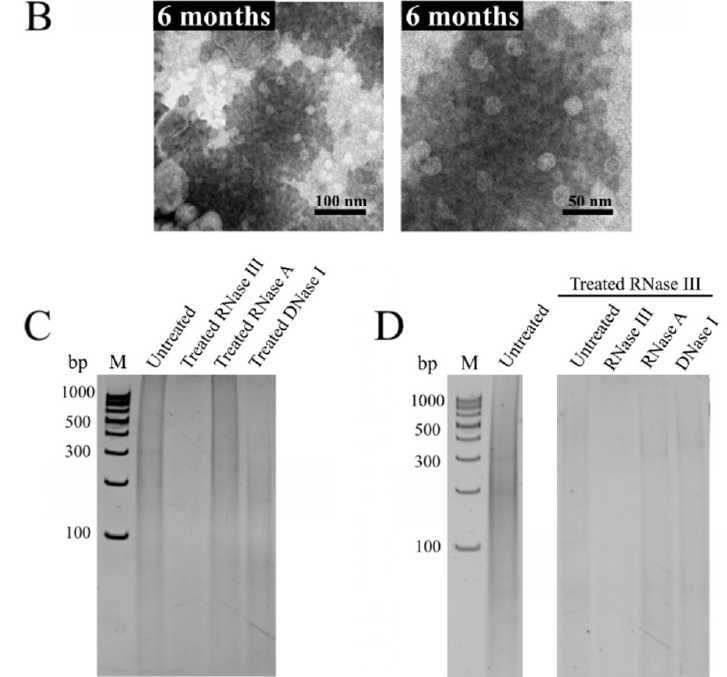
Figure 3. Characterization of recombinant Linked cp Pst DNV-ds pro counterpart. ( A ) Transmission electron micrograph of Linked cp Pst DNV-ds pro (Linked Pst DNV VLPs-ds pro ). ( B ) Linked Pst DNV VLPs-ds pro after 6-month storage at 4 ◦ C. ( C ) The presence of dsRNA on the outer surface of Linked Pst DNV VLPs-ds pro . Total RNA isolated from purified recombinant VLP was directly treated with either RNase III, RNase A or DNase I. ( D ) The encapsulated dsRNA in Linked Pst DNV VLPs-ds pro . Intrinsic dsRNA was confirmed by RNA isolation of RNase III-treated Linked Pst DNV VLPs-ds pro , followed by incubation with either RNase III, RNase A, or DNase I. All RNA products were ana ‐ lyzed on a 12 % TAE buffered - polyacrylamide gel . Lane M, GeneRuler 100 bp DNA Ladder (Thermo